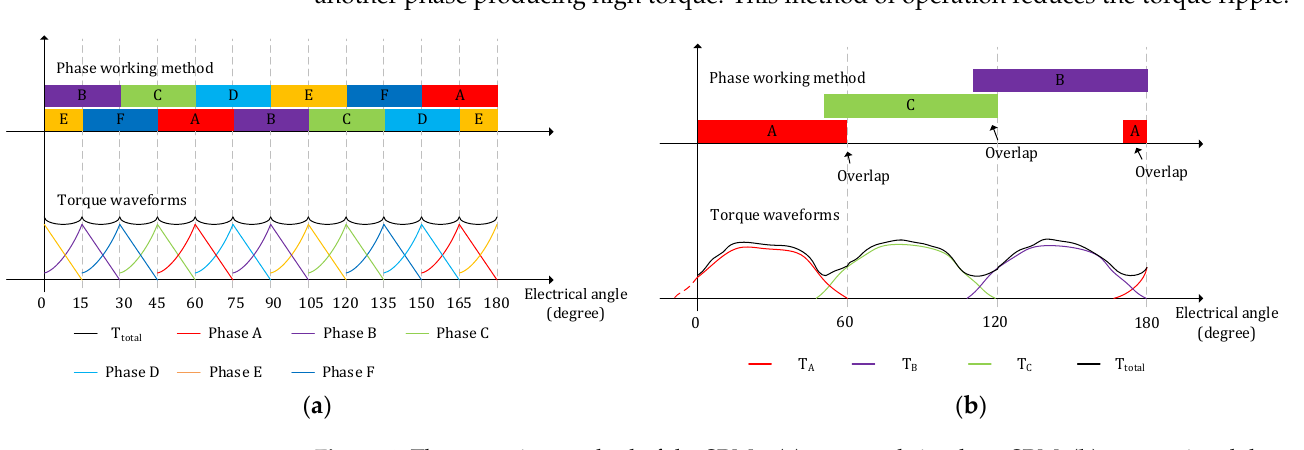
Figure 4. The operation method of the SRMs: ( a ) proposed six-phase SRM; ( b ) conventional three- phase SRM.